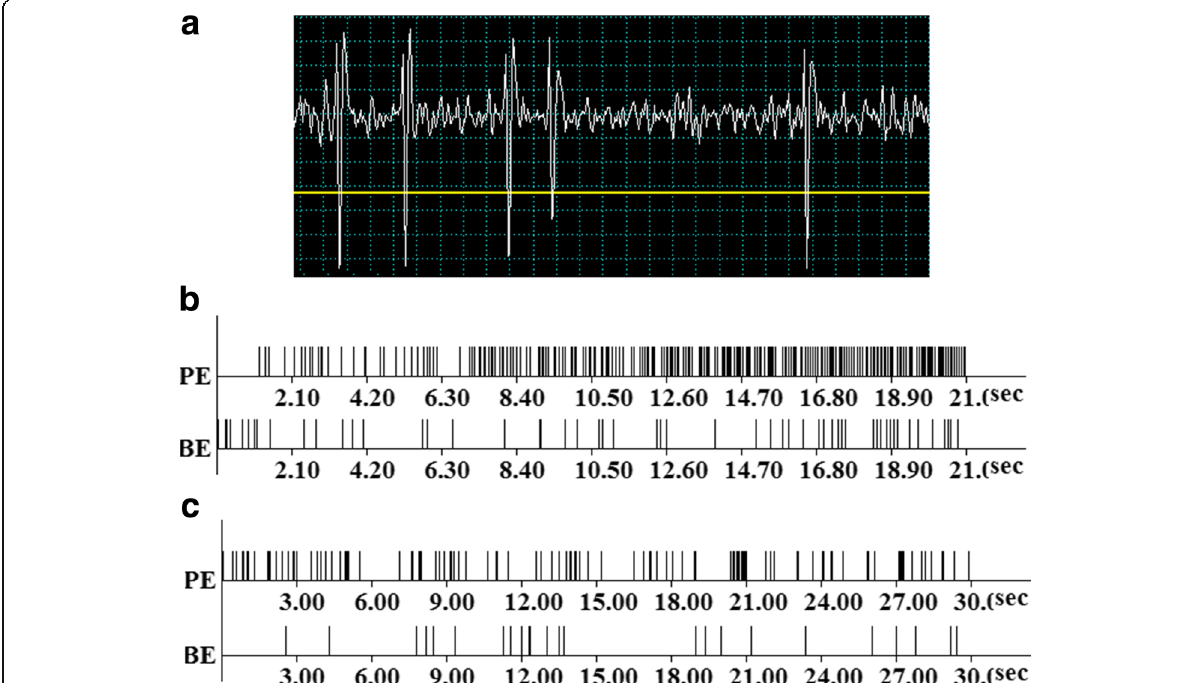
Fig. 1 Spike activity of a single neuron of the hippocampus (yellow line- amplitude discriminator) ( a ); prestimulus (BE - before event) and post-stimulus (PE - post event) spike activity in hippocampus ( b ) and amygdala ( c ) in real time 20 and 30 s before stimulation to high frequency stimulation (HFS during 1 s), exhibiting combinations of responses in the form of increased or deceleration frequency of the impulse stream – TD PTP ( b ) and TP PTP ( c